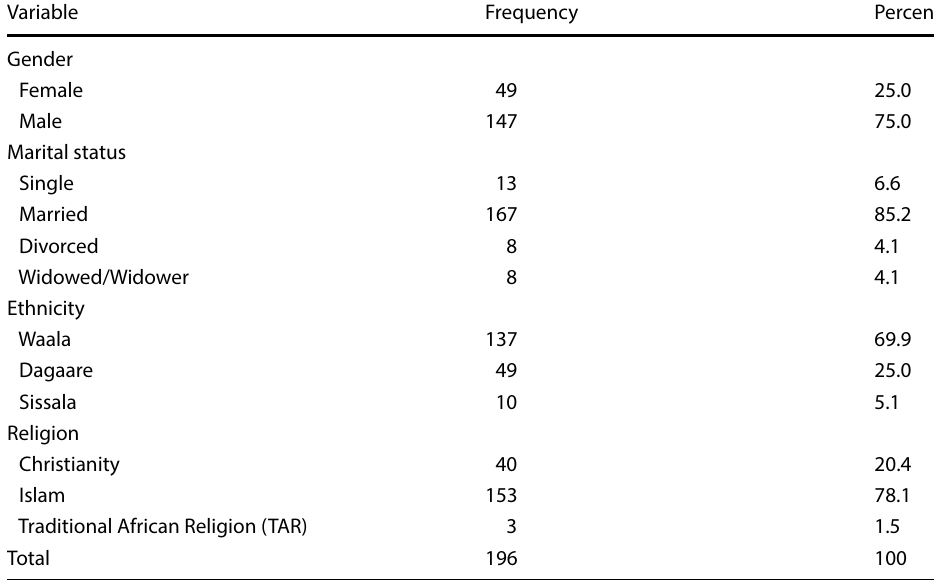
Table 2 Demographic characteristics of